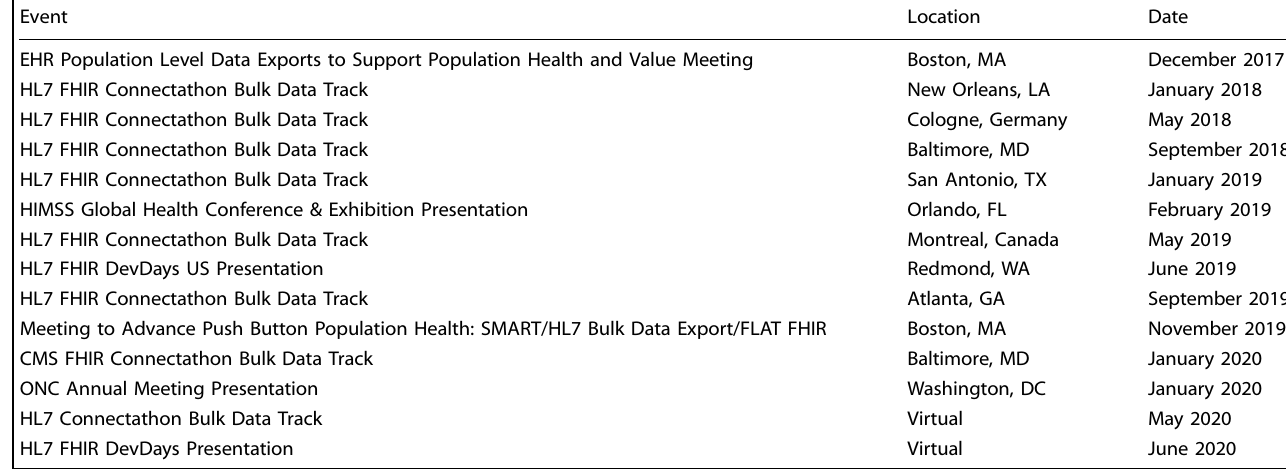
Table 3. SMART/HL7 FHIR Bulk Data Access API Meeting for development and